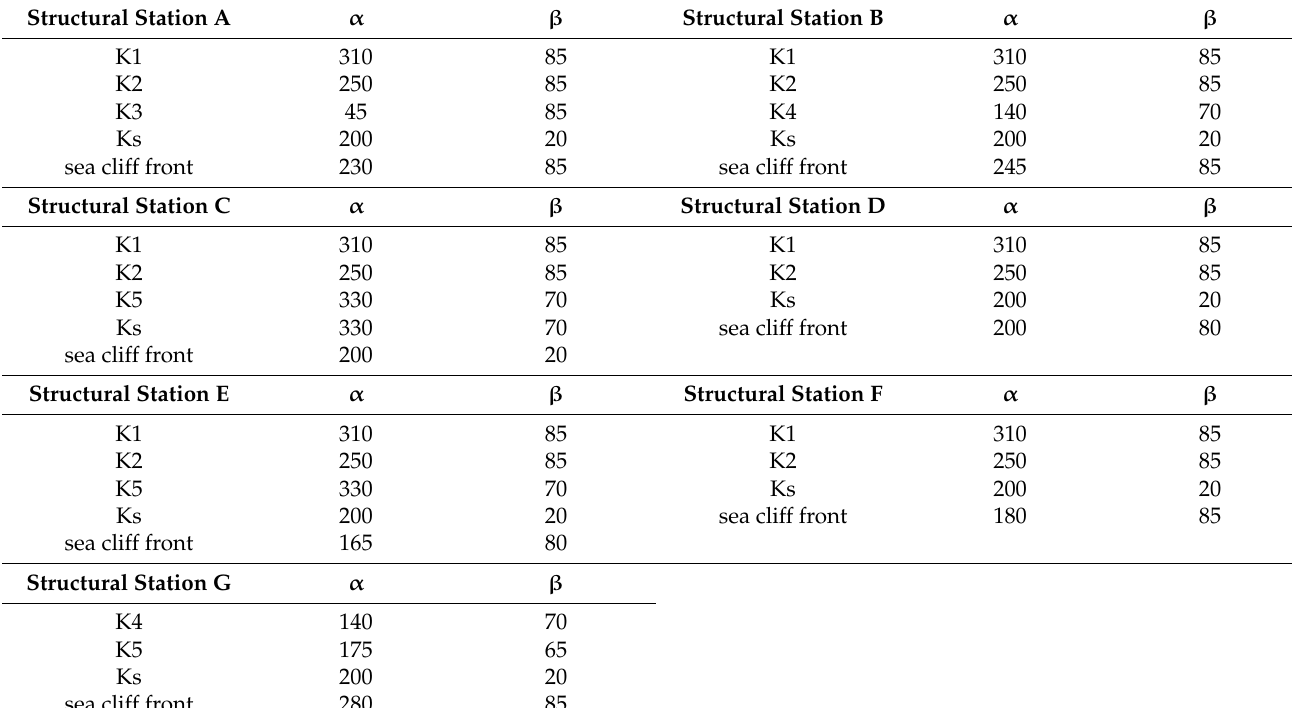
several low-equilibrium sectors in the sea cliff. More specifically, we recognized five systems of fractures and bedding whose dip-direction and dip are listed in Table 3. Table 3. List of fracture systems (K1 to K5) along the Coroglio-Trentaremi sea cliff with indication of the dip-direction ( α ) and dip ( β ). Bedding (Ks) and sea cliff front trend are also reported. Structural stations’ locations are reported in Figure 11. Structural Station A